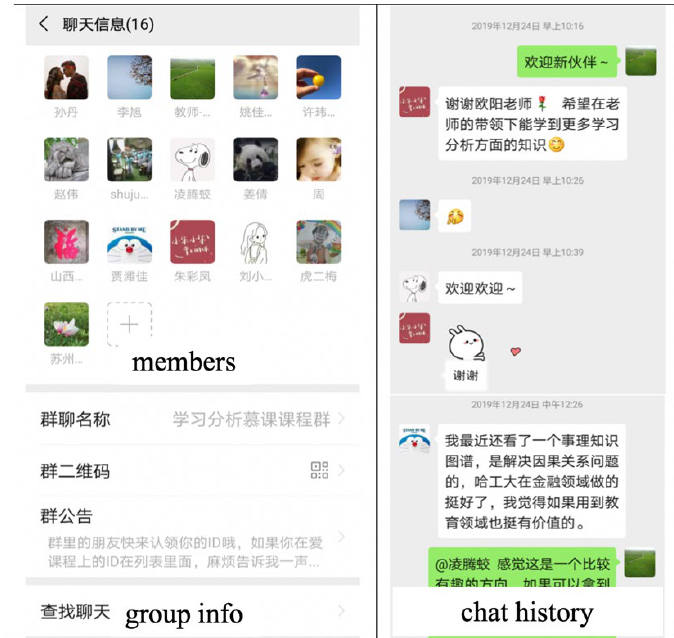
Figure 3. The WeChat